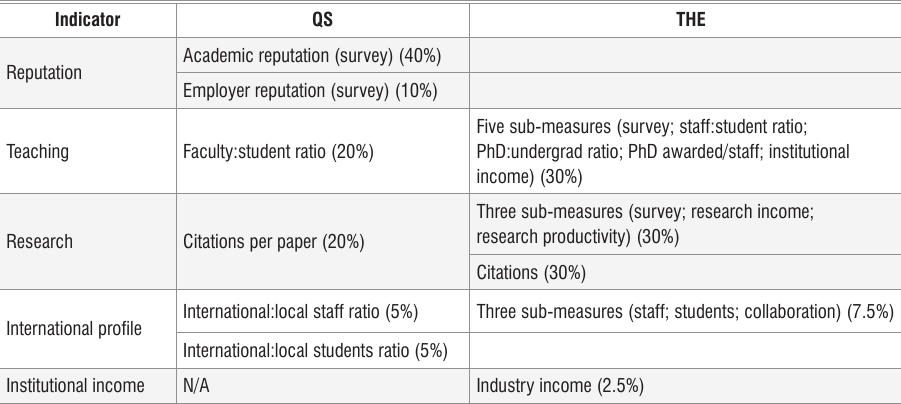
A comparison of the different indicators used by two university ranking systems: Quacquarelli Symonds (QS) and Times Higher Education (THE) Indicator QS THE Academic reputation (survey) (40%) Reputation Employer reputation (survey) (10%)